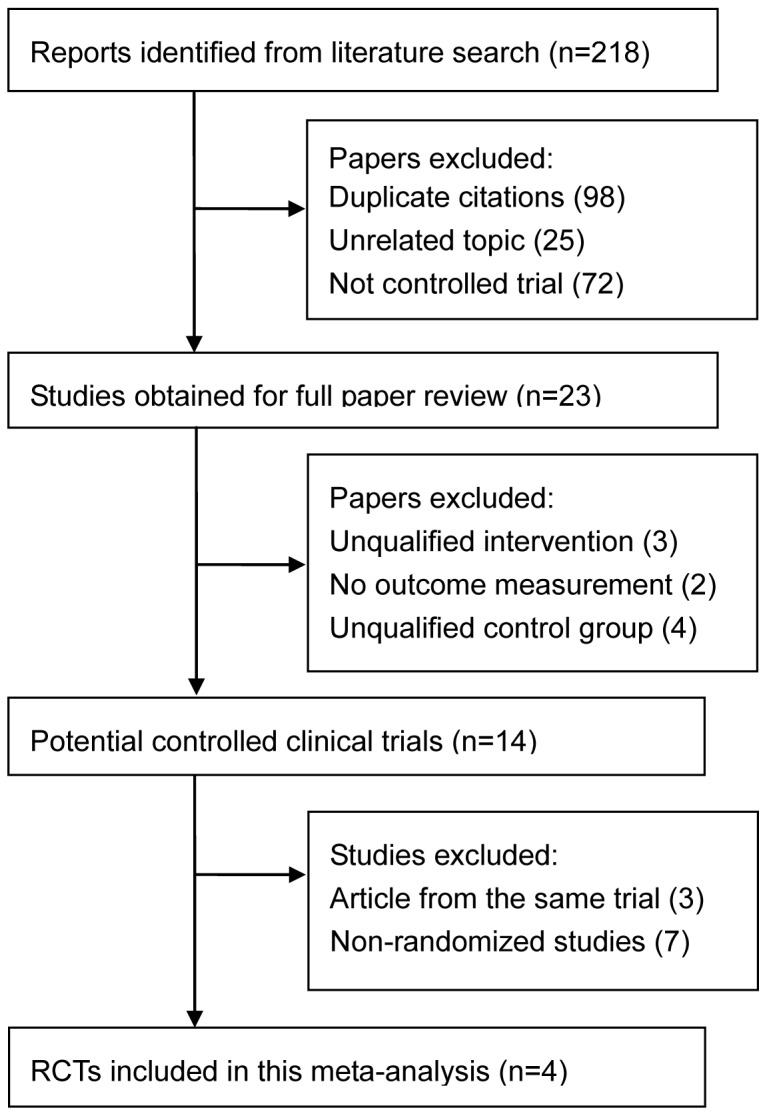
Flow of RCTs included in the meta-analysis.RCTs indicates randomized controlled trials.